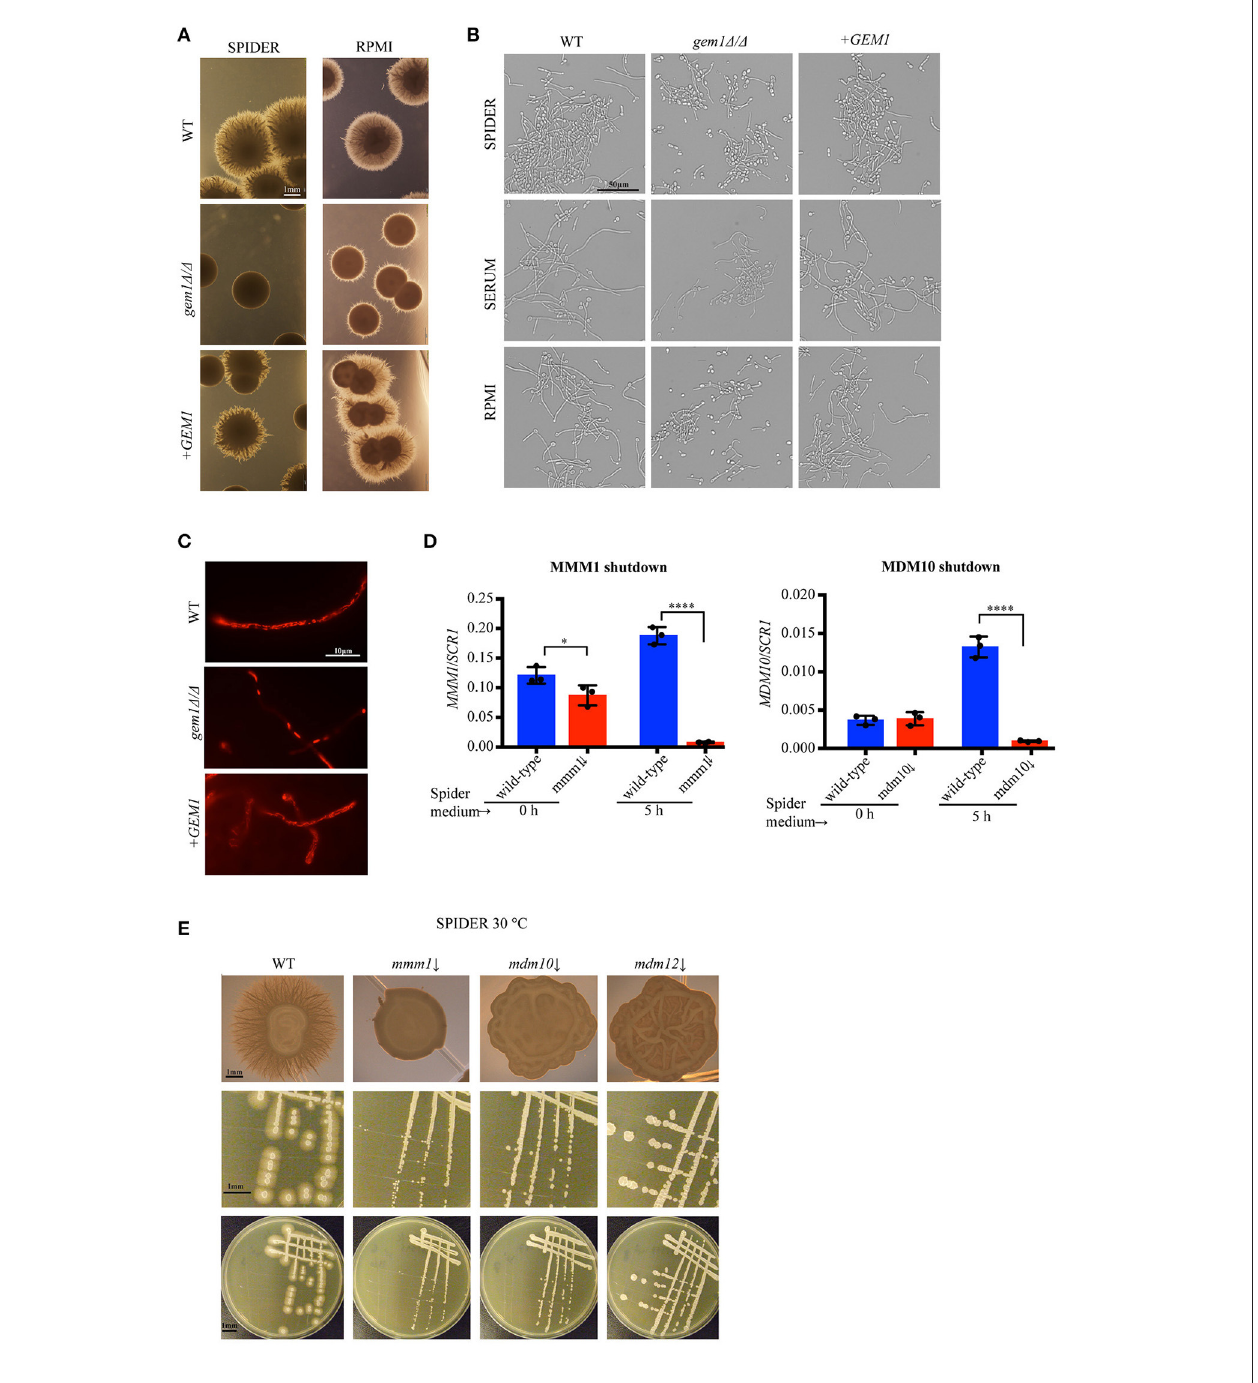
FIGURE 5 | Gem1 and ERMES function in invasive growth of C. albicans . (A) Filamentous growth of wild type (WT), gem1 1 / 1 and the complemented + GEM1 strain was tested on Spider and RPMI plates at 37 ◦ C. Pictures were taken after 5 days. (B) Filamentous growth of wild type (WT), gem1 1 / 1 and the complemented + GEM1 strain was tested in liquid Spider, YPD + 10% Serum and RPMI liquid media. Pictures were taken after 3h of incubation at 37 ◦ C. (C) Mitochondria of wild type (WT), gem1 1 / 1 and the complemented + GEM1 strain were stained with MitoTracker Red after incubation for 3h in Spider media. (D) Efficient repression of ERMES gene expression in the mmm1 ↓ and mdm10 ↓ strains in Spider media was confirmed by quantitative PCR. The mean and standard deviation of three independent experiments is shown. Statistical significance was determined by unpaired t -test with Welch’s correction* p < 0.03, **** p < 0.0001. (E) ERMES mutant strains mmm1 ↓ , mdm10 ↓ and mdm12 ↓ were grown on Spider plates and colony morphology was observed after incubation at 30 ◦ C for 5 days. Top row: single colony morphology of the indicated strains, middle row: close-up of selected areas of the plates (bottom row).